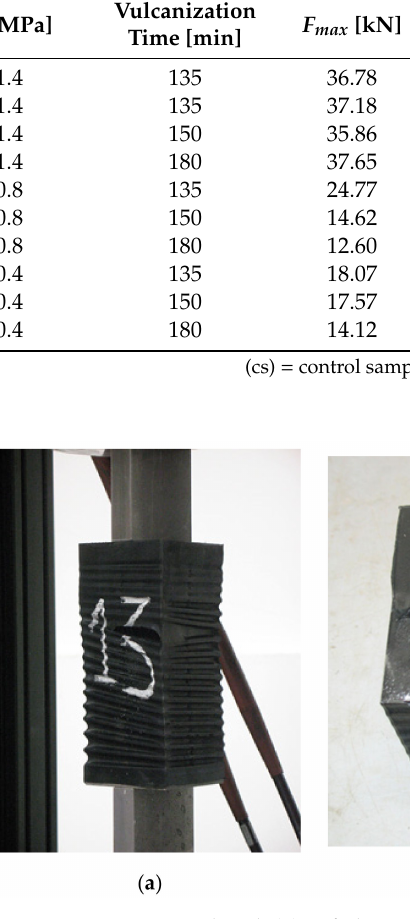
Figure 6. Sample 18b ( a ) at failure; ( b ) after mixed